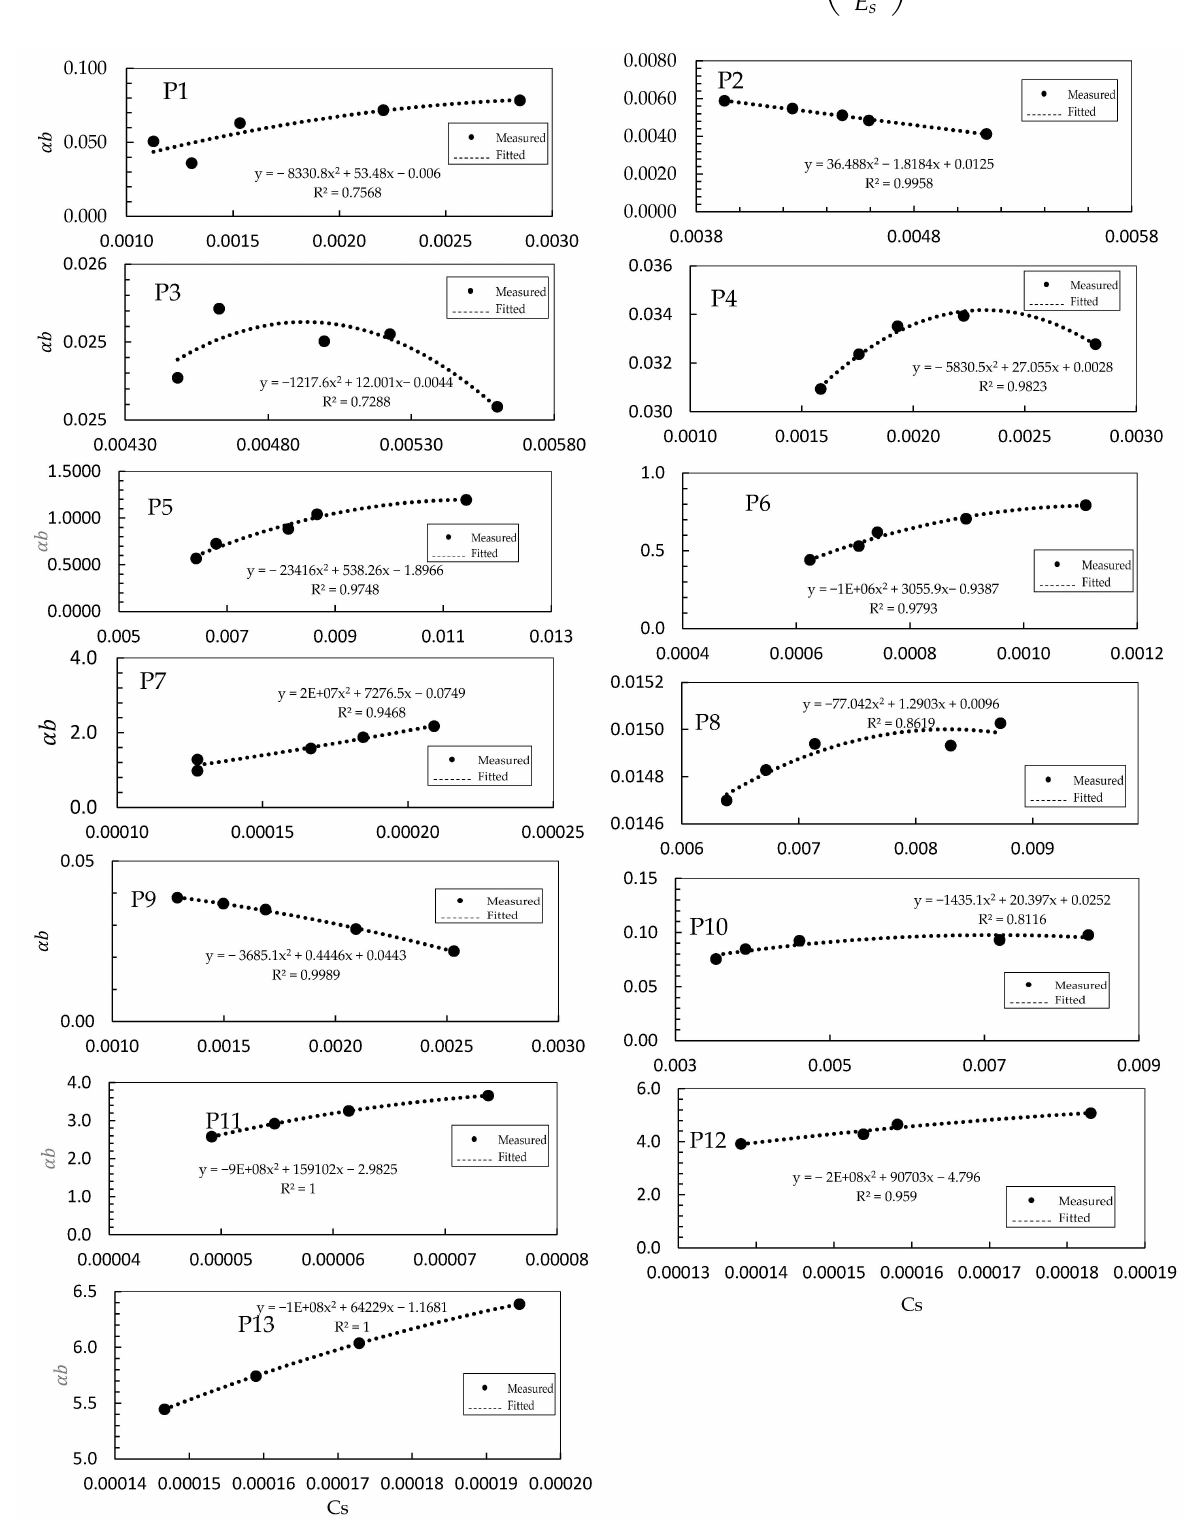
Figure 12. Variations in the drag coefficient factor α b with C s